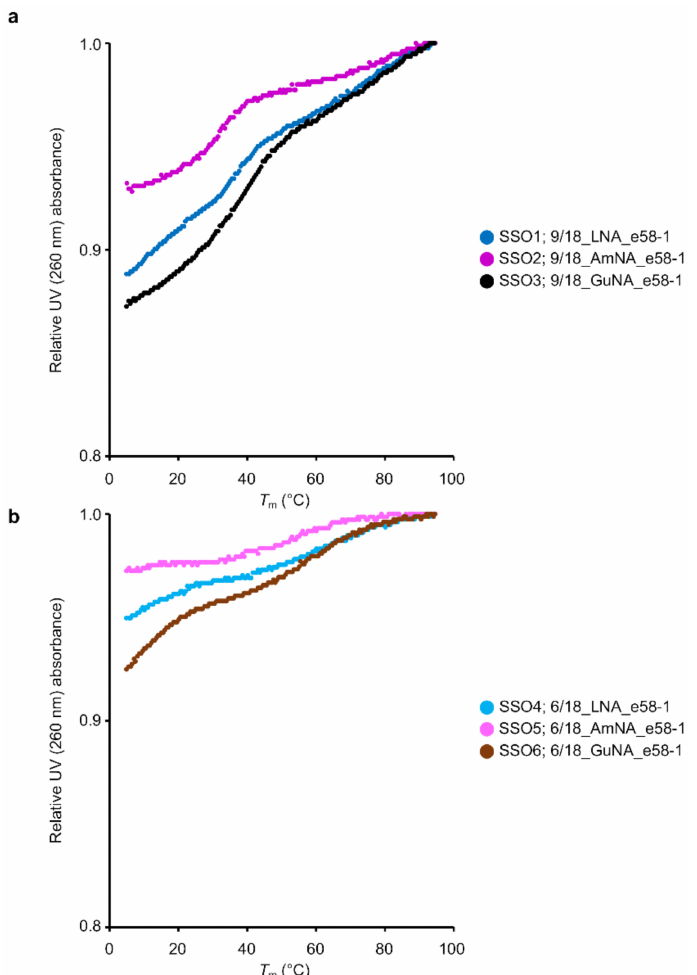
Figure 3. UV melting analysis of 18-mer LNA/AmNA/GuNA-modified SSOs targeting DMD exon 58 and having different modification content. ( a ) The result of UV melting experiments for single- stranded LNA-, AmNA-, and GuNA-modified SSOs having high modification content. ( b ) The result of UV melting experiments for single-stranded LNA-, AmNA-, and GuNA-modified SSOs having low modification content. All analyses were repeated three times to ensure reproducibility (see Supplementary Figure S1). The relative UV absorbance depicts normalized data (normalized by UV absorption at 94.5 ◦ C set to